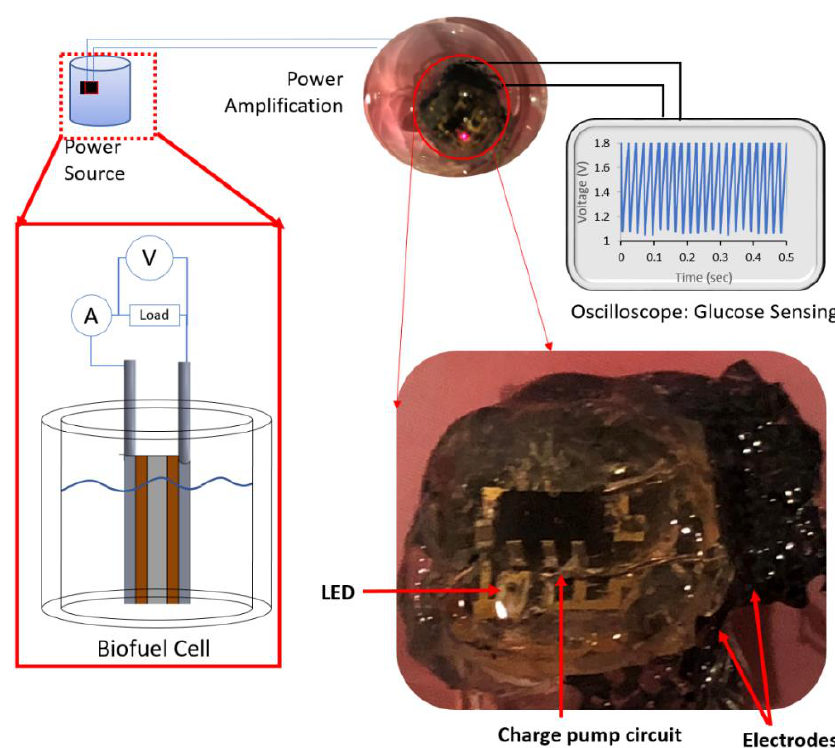
Figure 1. Experimental set-up of glucose biofuel cell and glucose sensing. Charge pump circuit consisting of a 0.1 µF capacitor functioning as a transducer, where the charge pump circuit is powered by the electrical power generated by the glucose biofuel cell.